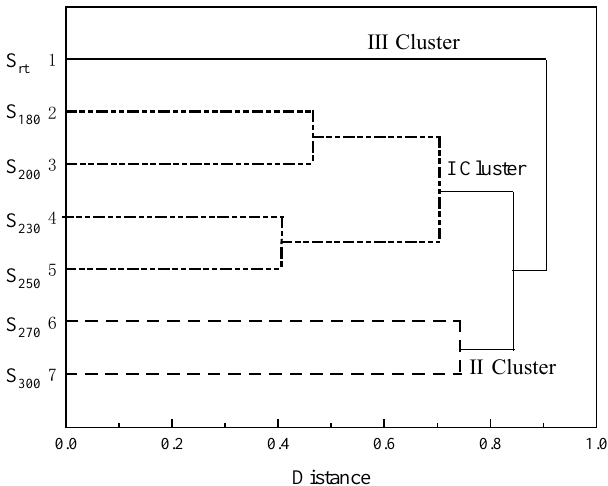
Figure 12. Dendrogram of the oil samples by cluster analysis based on the average linkage and Pearson correlation coe ffi